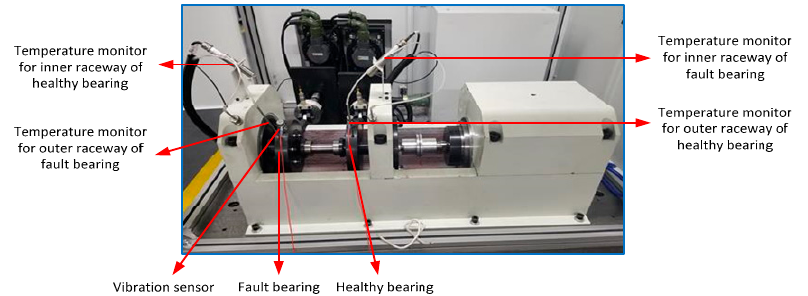
Figure 29. Experiment rig from real measurement.